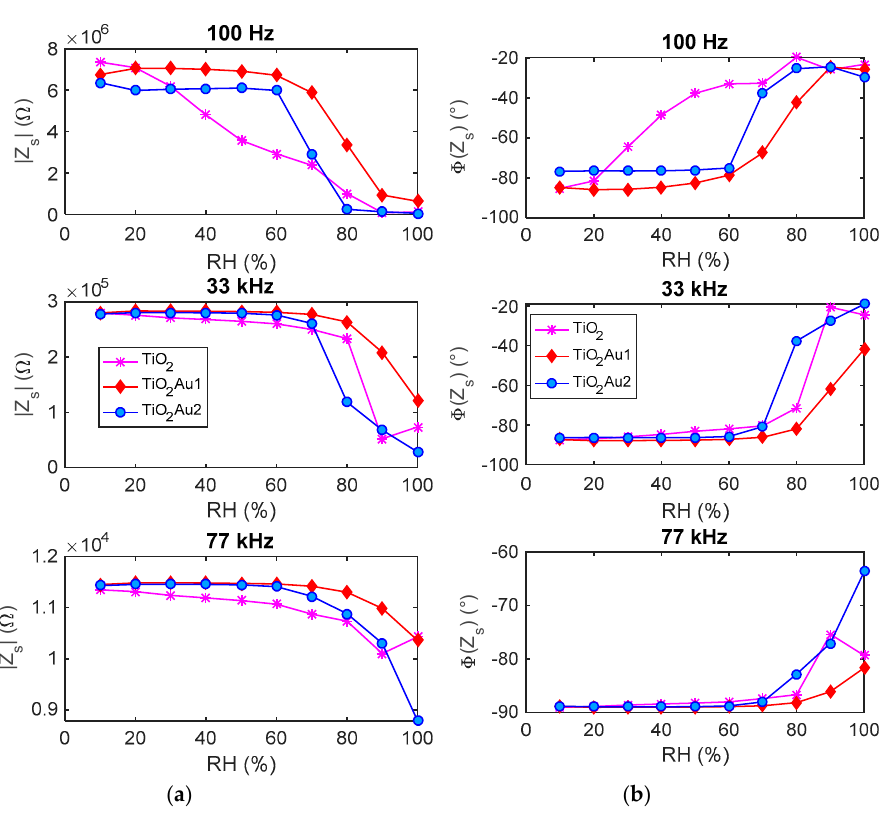
Figure 10. Impedance magnitude ( a ) and phase ( b ) of the tested sensing devices as a function of the RH value measured with the commercial sensor in the measurement chamber, evaluated at 100 Hz (upper plots), 33 kHz (middle plots), and 77 kHz (lower plots), respectively.